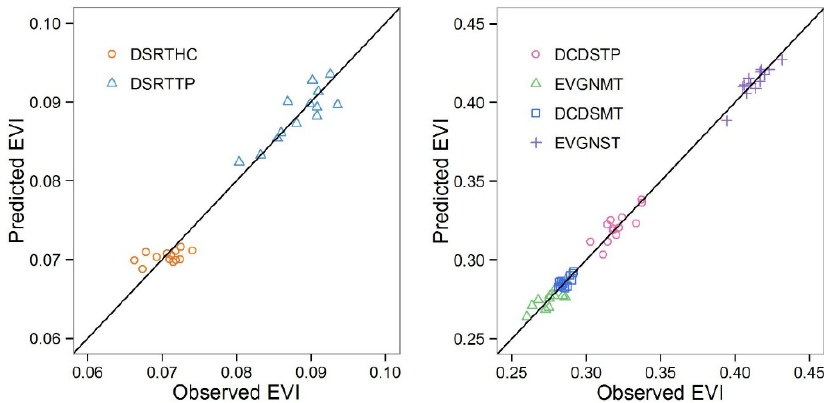
Figure 3. Regression of annual averaged EVI of the six shrubland types on pertinent climate variables: Regression predicted vs. observed values. Observed EVI indicates EVI obtained from MODIS and predicted EVI indicates values predicted by generalized least square based regression model.